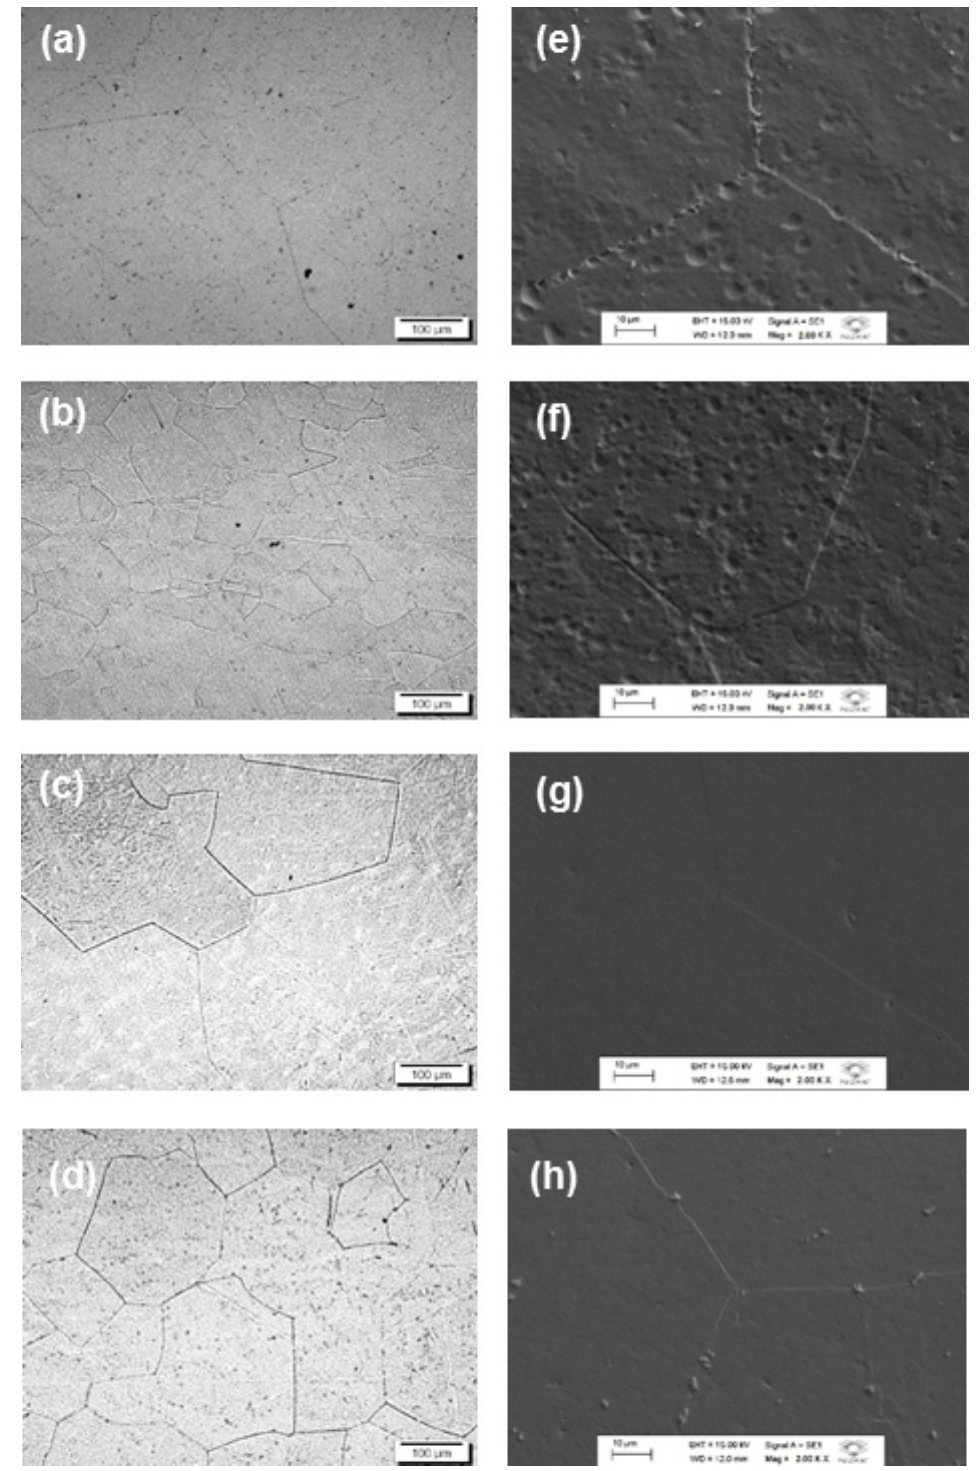
Figure 4. Optical micrographs of the Ti-5Mn-15Mo alloy after homogenization ( a ), hot-rolling ( b ), and solution ( c ) and annealing ( d ) treatments. SEM micrographs of the Ti-5Mn-15Mo alloy after homogenization ( e ), hot-rolling ( f ), and solution ( g ) and annealing ( h ) treatments.